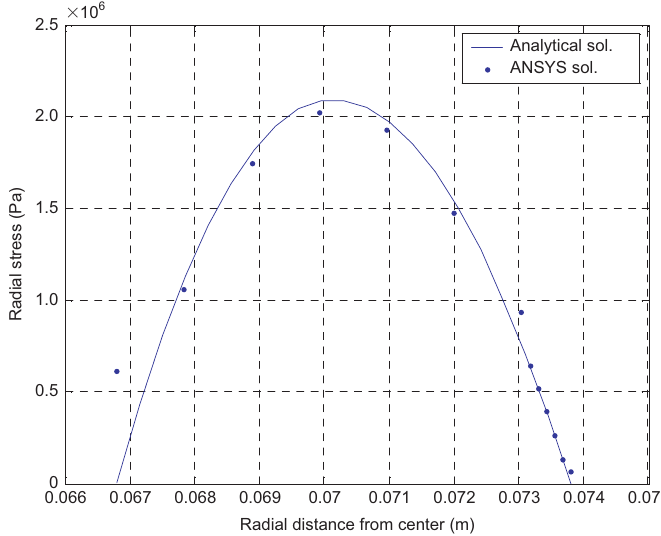
Figure 21 Thermally induced radial stresses as a function of radial distance from center for an isotropic